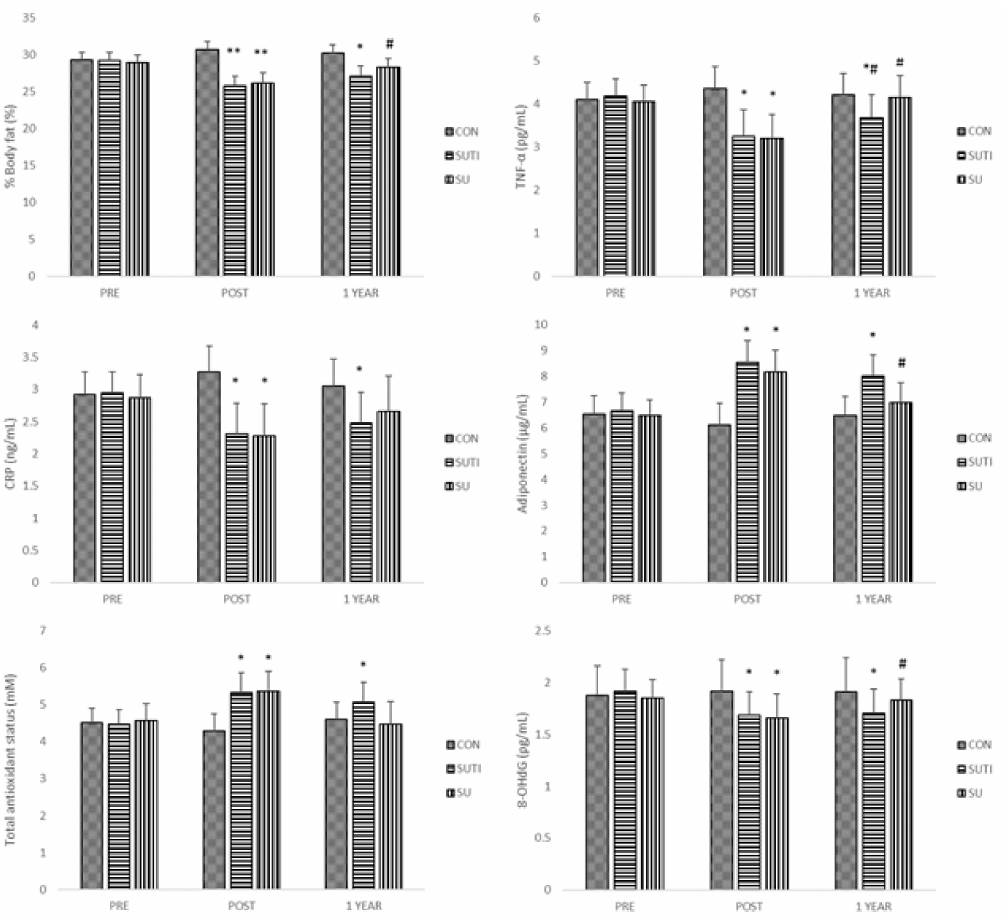
Figure 1. Changes in %body fat, markers of inflammation and oxidative stress at baseline (PRE), after 8 week summer camp (POST), and after 10 month follow-up (1YEAR). Values are means ± SEM . CON, control; SUTI, summer camp + 10 month telephone intervention; SU, summer camp only; TNF- α , tumor necrosis factor-alpha; CRP, C-reactive protein; *, di ff erent from PRE ( p < 0.05); **, di ff erent from PRE ( p < 0.01); #, di ff erent from POST ( p <